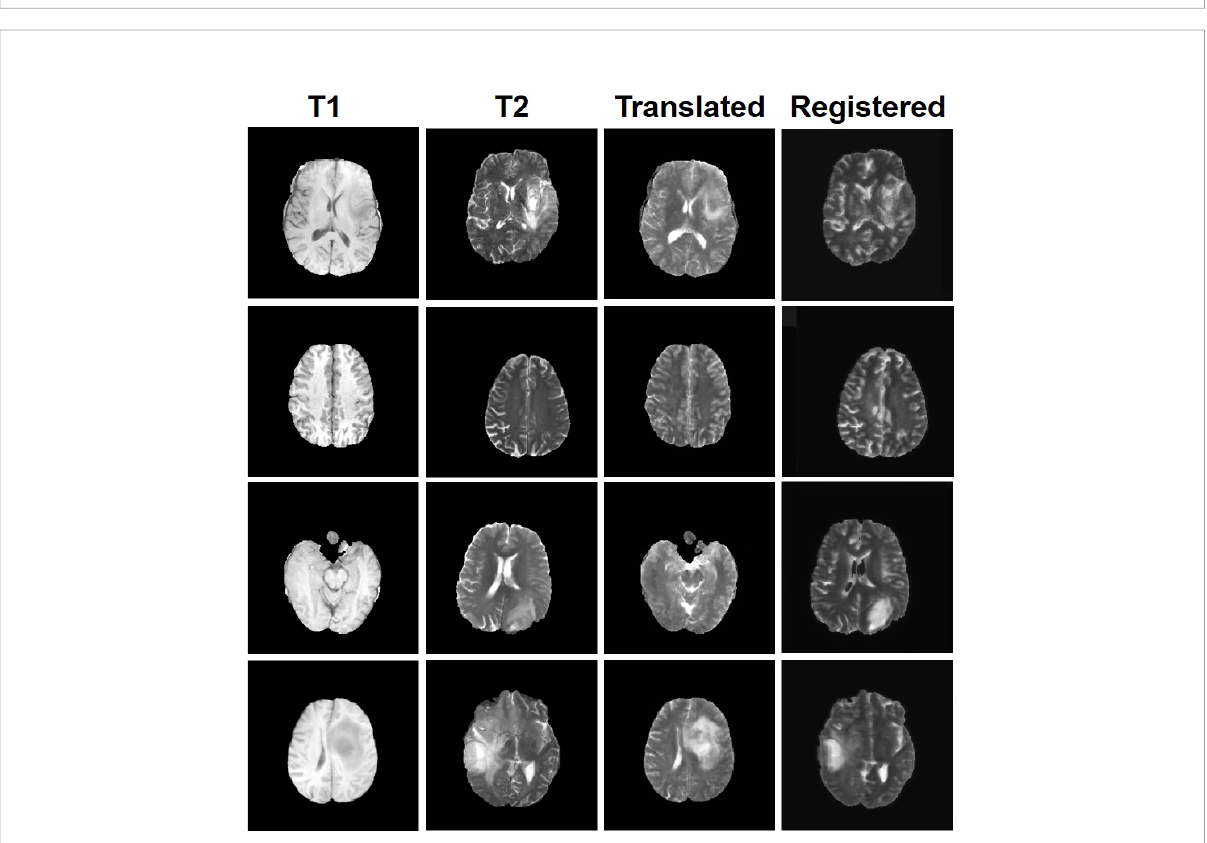
FIGURE 7 Display of MMTrans output on unpaired data. T1 and T2 are unpaired images. Translated represents the translation result of T1 to T2. Registered represents the registration result of the translated